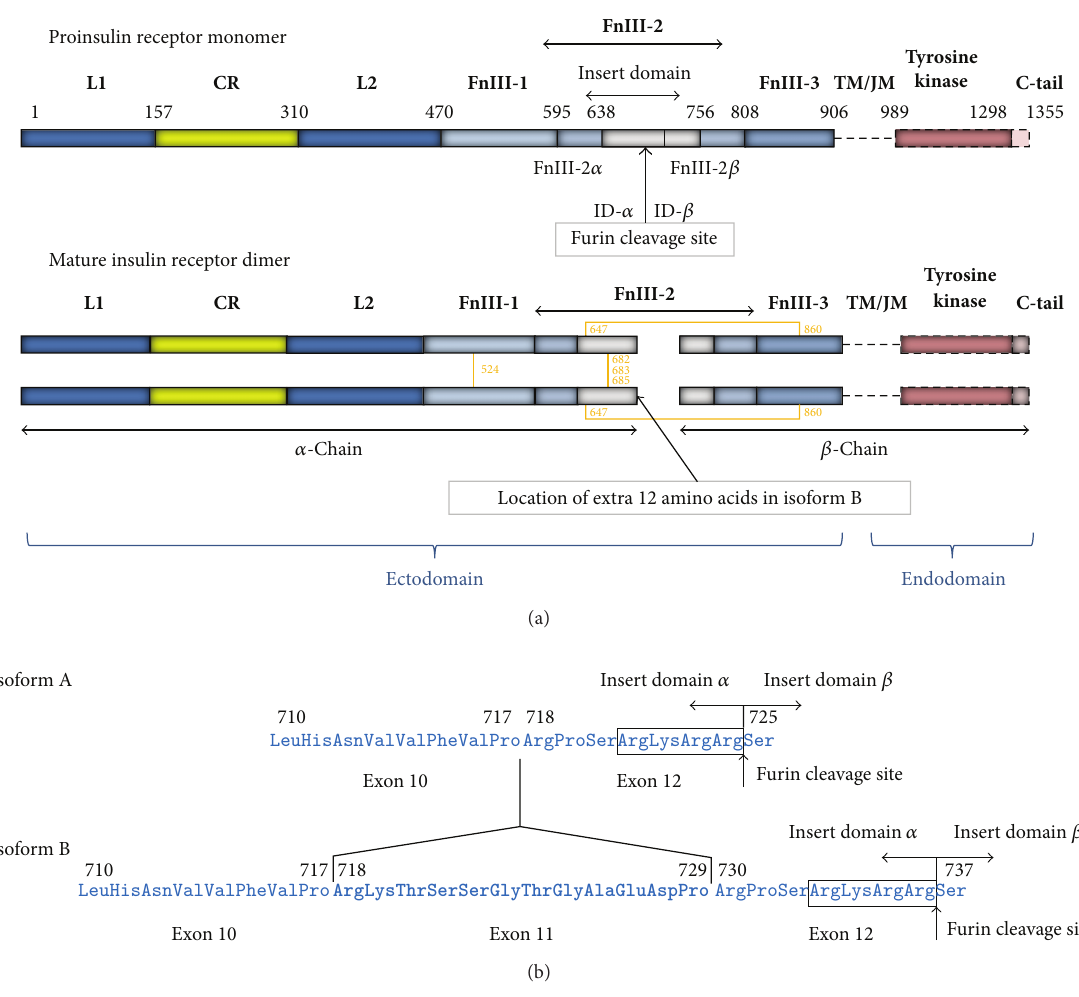
Figure 6: Representation of the domain structure of the human insulin and type I IGF receptors. The insulin receptor and type I IGF receptor aresynthesisedassinglepolypeptidechainsthatcompriseseveralcongruent,distinctdomains.Alinearrepresentationofthedomainstructure of the proinsulin receptor isoform B after the removal of the signal peptide is shown above, a representation of the homodimer (a). From the amino-terminus, the individual domains are coloured as follows: leucine-rich repeat domain 1 (L1, blue), a cysteine-rich region (CR, yellow), a second leucine-rich repeat domain (L2, blue) followed by three fibronectin type III domains (FnIII-1, FnIII-2, and FnIII-3, different shades of pale blue). FnIII-2 is interrupted by a ∼ 120 residue insert domain (ID, grey) that contains the furin proteolytic cleavage site which is cleaved by a protease to create the 𝛼 and 𝛽 chains of the receptors. The segments of the insert domain that are in the 𝛼 and 𝛽 chains are termed ID 𝛼 and ID 𝛽 , respectively. The single helix that spans the plasma membrane (TM, dashed line) is C-terminal to the FnIII-3 domain and is followed by the intracellular domains comprising a ∼ 40 amino acid residue intracellular juxtamembrane region (JM, dashed line), a tyrosine kinase (TK) catalytic domain, and an ∼ 60 amino acid residue carboxyl-terminal tail. Intramonomer and intermonomer disulphide bonds are shown as ochre coloured connecting lines. The position of the furin cleavage site is indicated below the proinsulin receptor monomer and the position of the extra 12 amino acid residues present in isoform B of the insulin receptor is indicated below the depiction of the mature insulin receptor dimer. The amino acid sequences around the furin cleavage sites in isoform A and isoform B [311] of the insulin receptors are shown (b). The additional 12 residues encoded by exon 11 that are present in isoform B of the insulin receptor are shown in bold. The presence of 12 additional residues, three amino acids from the carboxy-terminus of the 𝛼 -chain, in the 𝛼 -chain insert domain impinges upon Site 1 of the insulin receptor binding pocket [84] and affects the ability of IGF-1 and IGF-2 to interact with the insulin receptor isoform